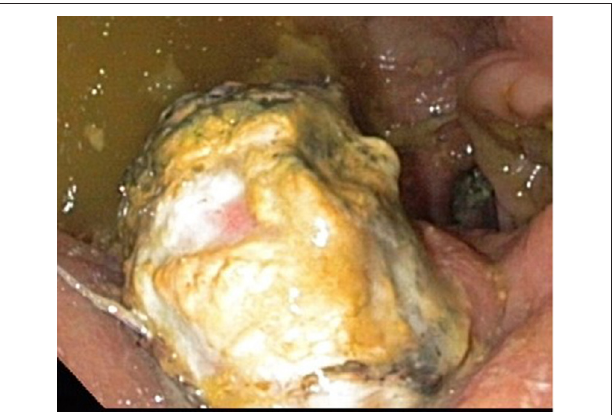
FIGURE 4 | Pancreatic stump of patient 5 (POPF Grade